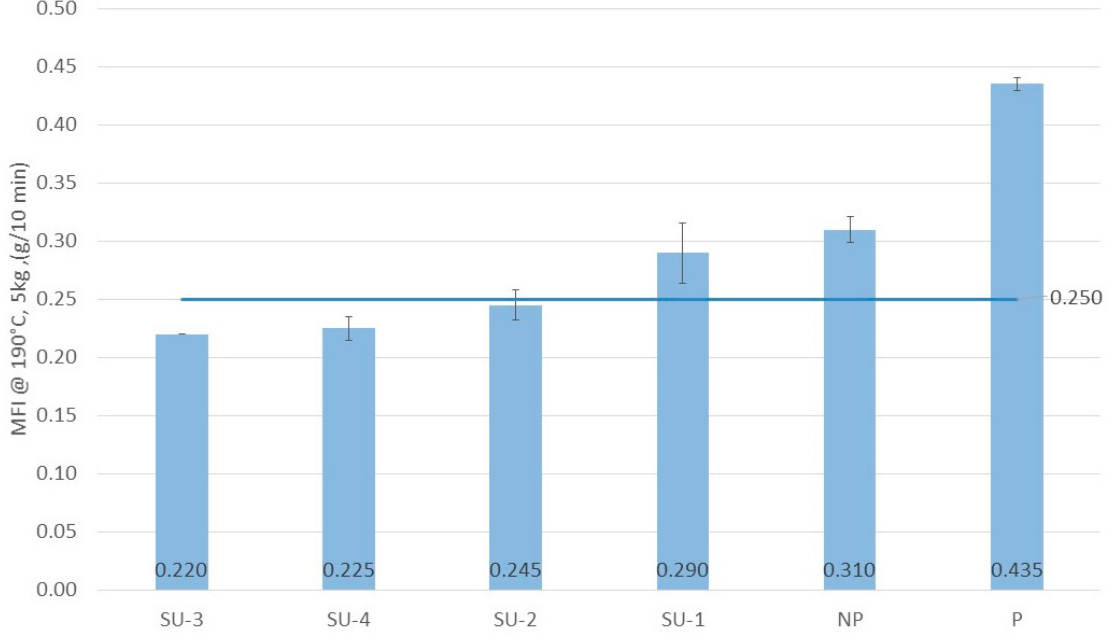
Figure 7. The melt flow index (MFI) of the samples from the scaled-up experiment.